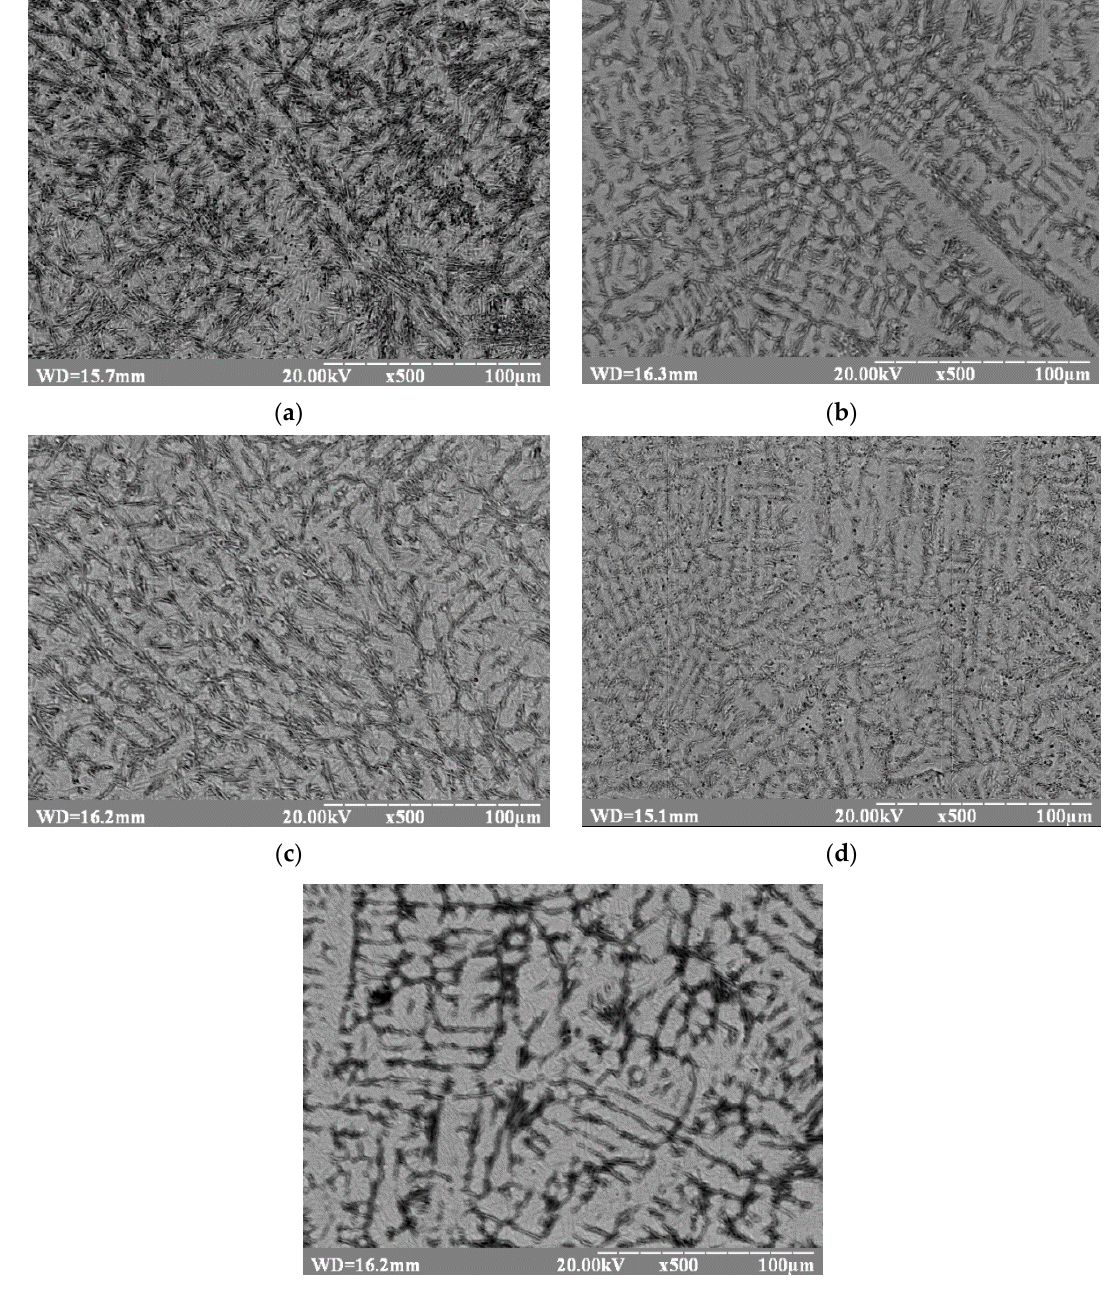
Figure 18. Microstructures of the welded seam material of the (Ti-TiB)–T110 joint: ( а ) v eb = 7 mm·s −1 , T 0 = 20 °С; ( b ) v eb = 10 mm·s −1 , T 0 = 20 °С; ( c ) v eb = 13 mm·s −1 , T 0 = 400 °С; ( d ) v eb = 13 mm·s −1 , T 0 =20 °С; ( e ) v eb = 13 mm·s −1 , T 0 =600 °С.